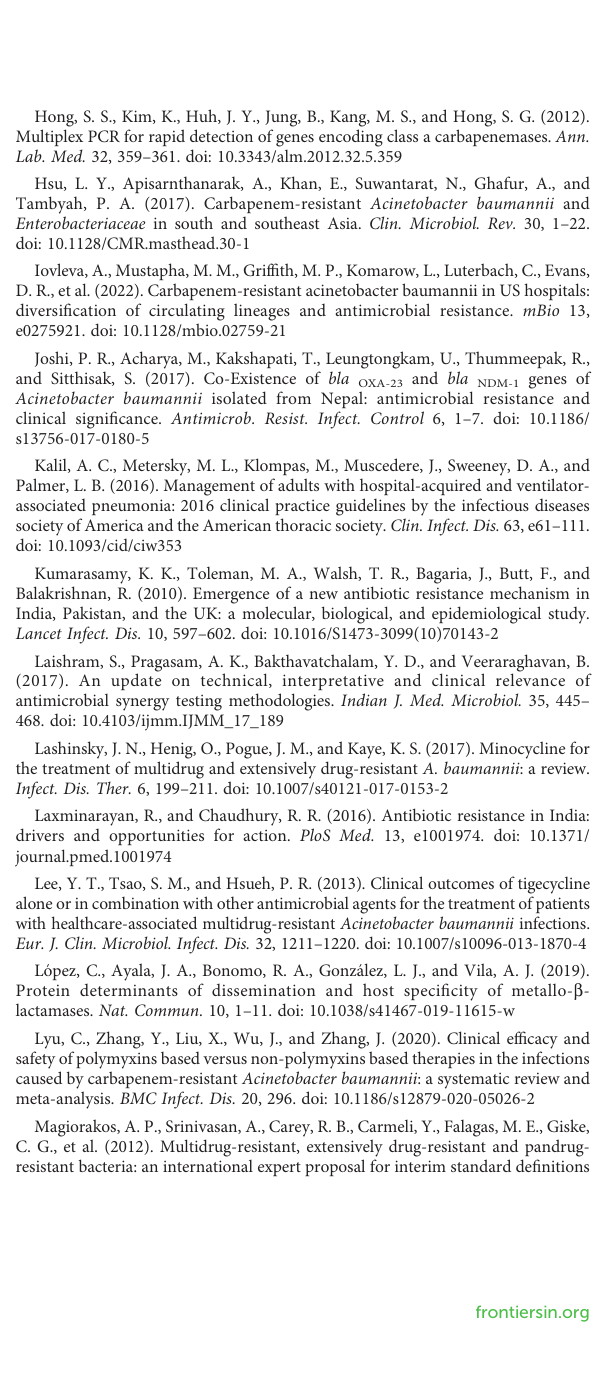
SUPPLEMENTARY FIGURE 1 Dendrogram by Rep-PCR of 100 CRAB isolates included in drug synergism